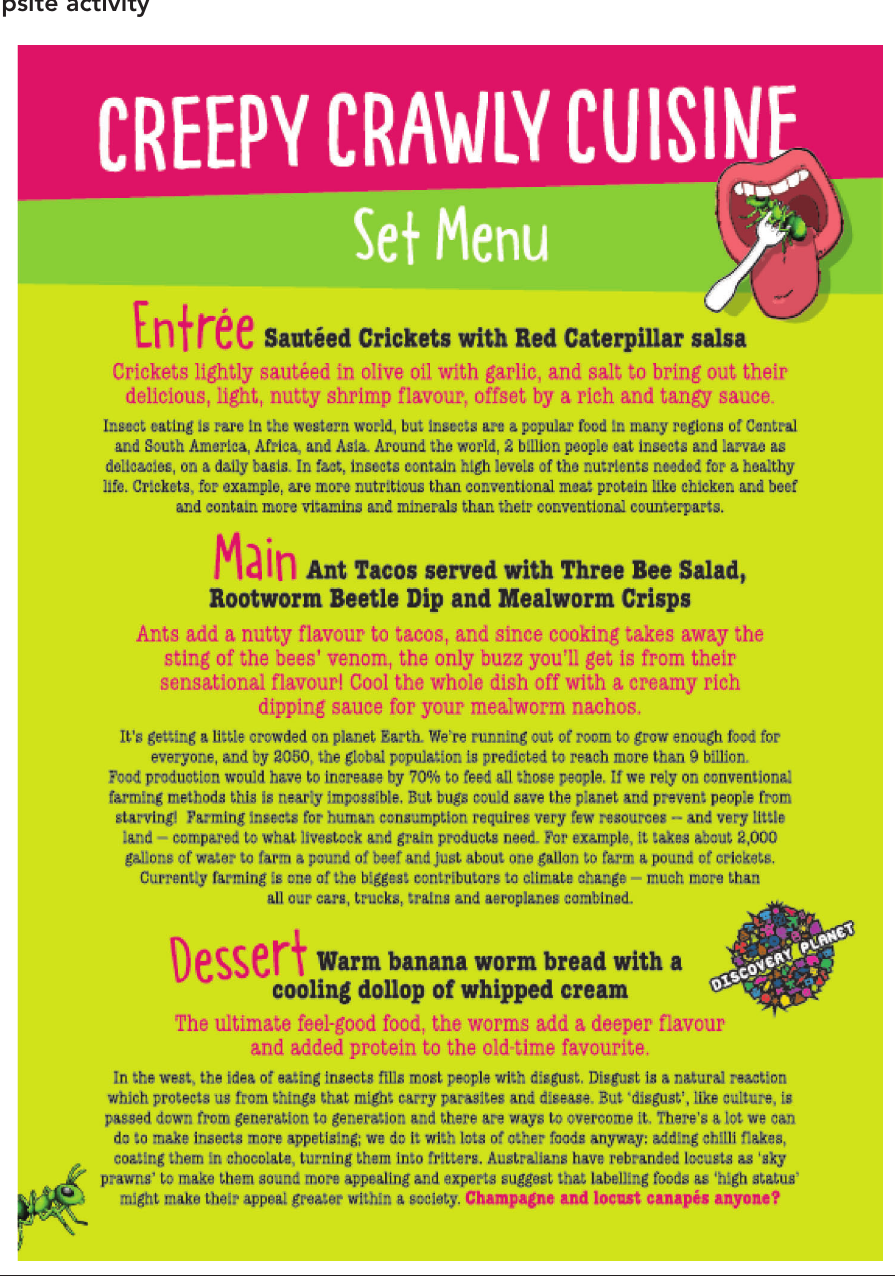
Figure 4: The ‘Creepy Crawly Cuisine’ menu that Discovery Planet produced for the campsite